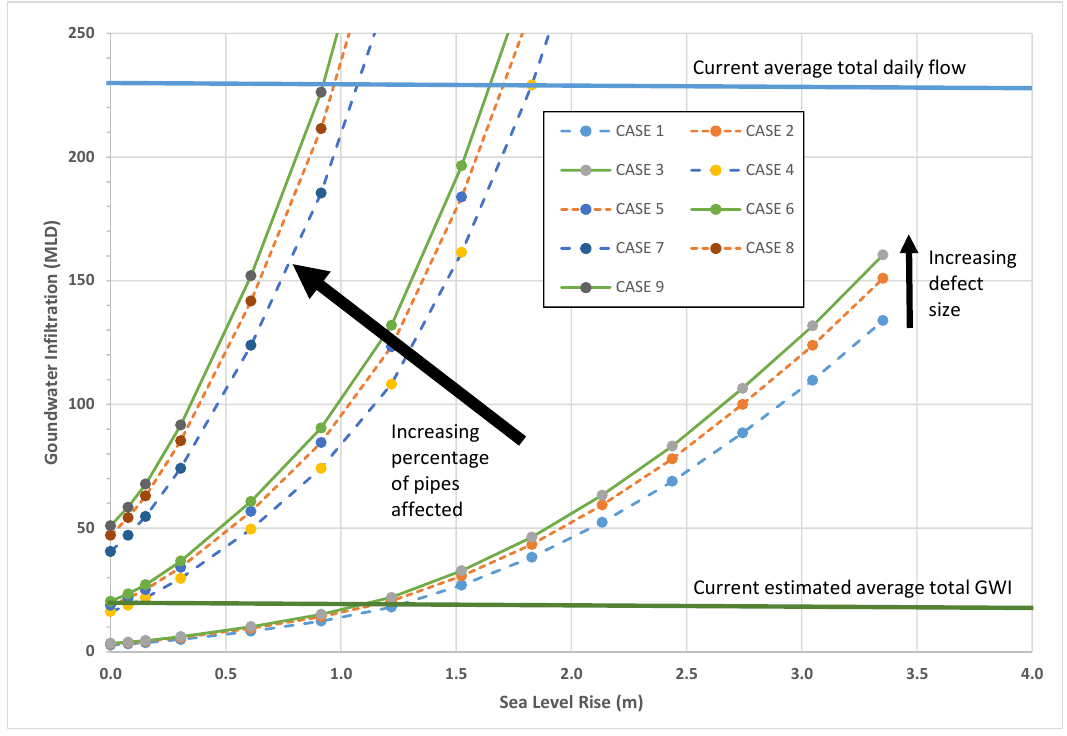
Figure 7. Projected GWI as a function of groundwater head above sewer pipes in Downtown Honolulu.